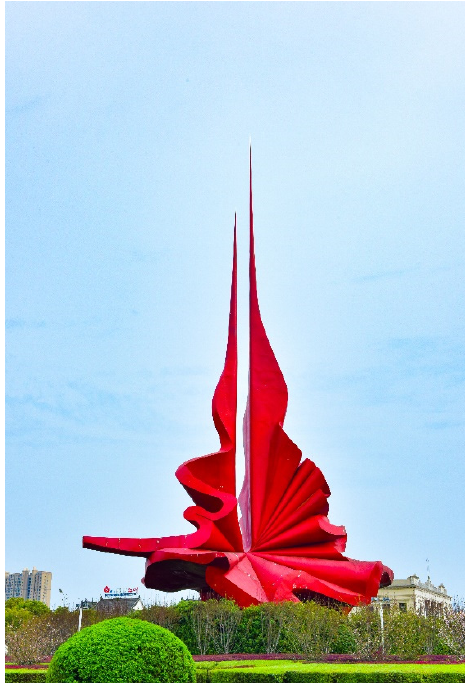
Figure 2. Public artwork “The Torch”.